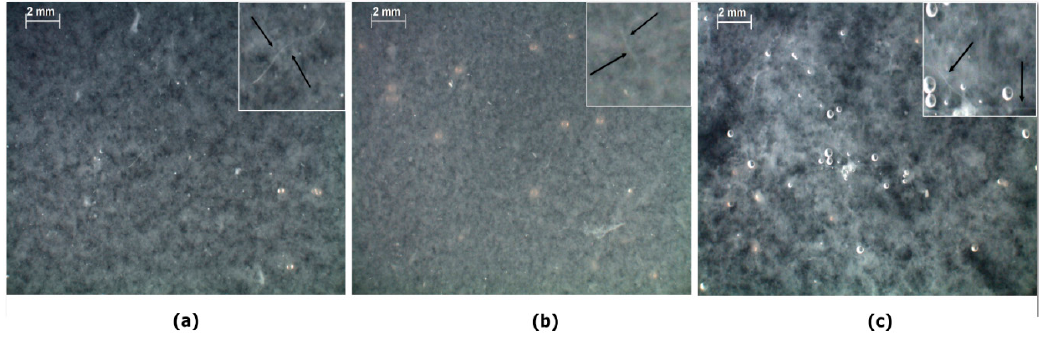
Figure 3. Optical microscope images of blend solutions after dialysis with the starting ratios (before dialysis) of: ( a ) Col/RSF: 75/25; ( b ) Col/RSF: 50/50; and ( c ) Col/RSF: 25/75. Arrows indicates fibril formation in the system.